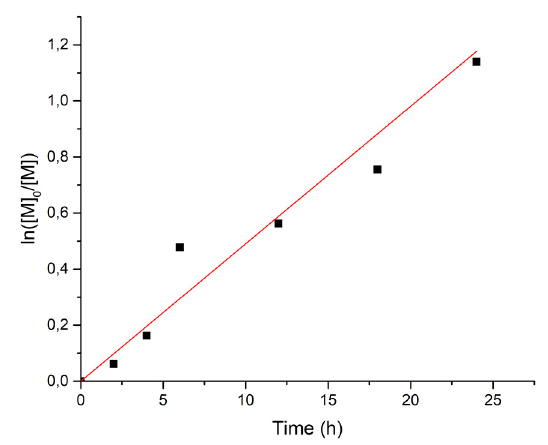
Figure 1. First-order kinetics plot for the polymerization of VDF in the presence of [Mn(CF 3 )(CO) 5 ] initiated thermally (100 °C).